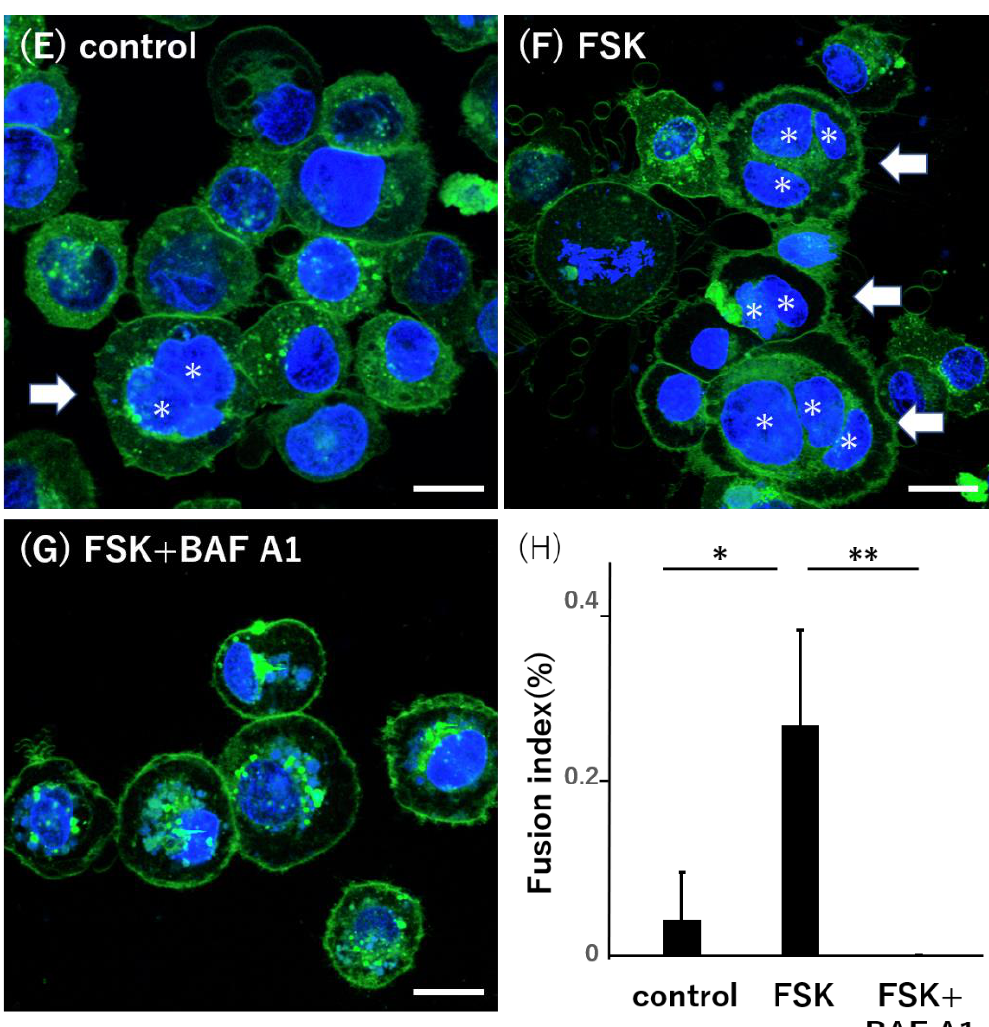
Figure 3. Failure of differentiation and fusion in BeWo cells induced by autophagy inhibition. An autophagy inhibitor, bafilomycin A1 (BAF A1) 20 nM, or autophagy activators, Torin1 10 nM or Tat-Beclin1 (T-B1) 20 µ M, was administered in the presence of Forskolin (FSK). Protein expression of CYP11A1 was evaluated as an indicator of syncytialization ( A ). The graph showed the CYP11A1 level in each group ( B ). The protein levels of p21, a senescent marker induced by FSK, are shown in the presence or absence of BAF A1 20 nM ( C ). The graph shows the p21 level in each group ( D ). BeWo cells were cultured for 72 h as a control ( E ), treated with FSK 25 µ M for 72 h to promote fusion ( F ), and simultaneously treated with BAF A1 ( G ). The cell membrane was stained with Di-8-ANESS (green) and nuclei with DAPI (blue). The fused cells, which are indicated with arrows, included multiple nuclei indicated with asterisks. Scale bar: 20 µ m. The fusion index, which is calculated with number of fused cell nuclei/total number of nuclei, is shown in ( H ). Six randomly selected fields of view were captured and used for analysis. The graphs were obtained from the three independent results. A significance test was performed: * p < 0.05, and ** p < 0.01.